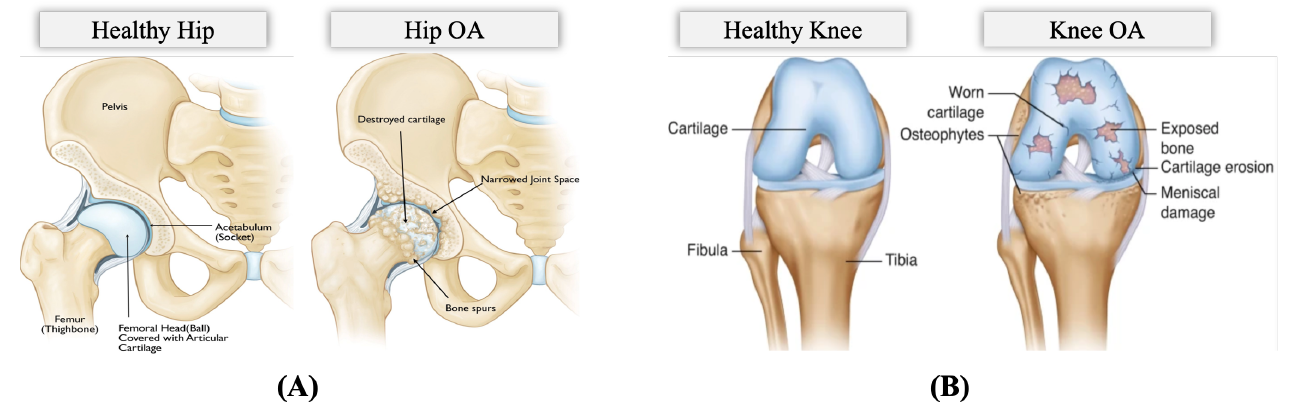
Figure 2. Anatomy of ( A ) Hip Osteoarthritis vs. Normal Hip (Reproduced with permission from OrthoInfo. © American Academy of Orthopaedic Surgeons. https://orthoinfo.org/ accessed on 26 March 2022) [19], ( B ) Knee Osteoarthritis vs. Normal Knee (rights in the images are owned by a third party)